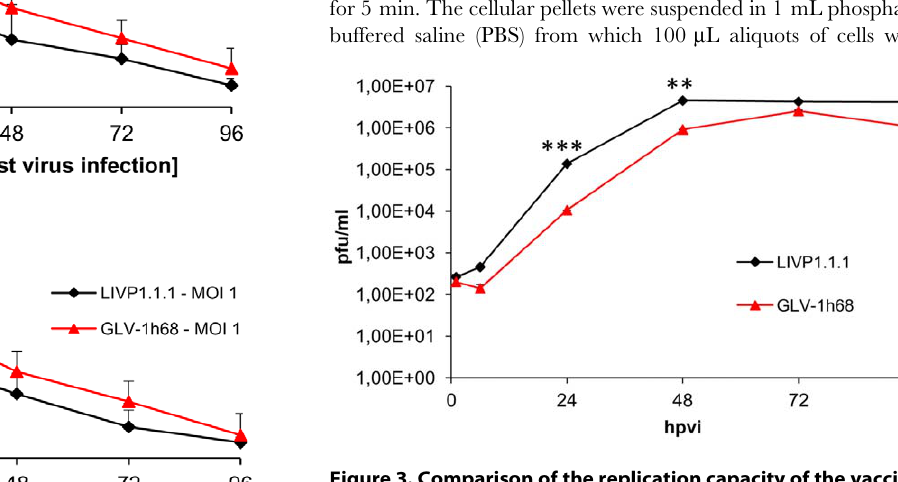
Figure 3. Comparison of the replication capacity of the vaccinia virus strains GLV-1h68 and LIVP1.1.1 in canine soft tissue sarcoma cells. For the viral replication assay, STSA-1 cells grown in 24- well plates were infected with either GLV-1h68 or LIVP1.1.1 at an MOI of 0.1. Cells and supernatants were collected for the determination of virus titer at various time points. Viral titers were determined as pfu per well in triplicates by standard plaque assay in CV-1 cell monolayers. Averages plus standard deviation are plotted. The data represent two independent experiments. The statistical significance was analyzed using two-way ANOVA followed Bonferroni post-test on log trans- formed PFU data. *, **, and *** indicate P , 0.05, 0.01, and 0.001,